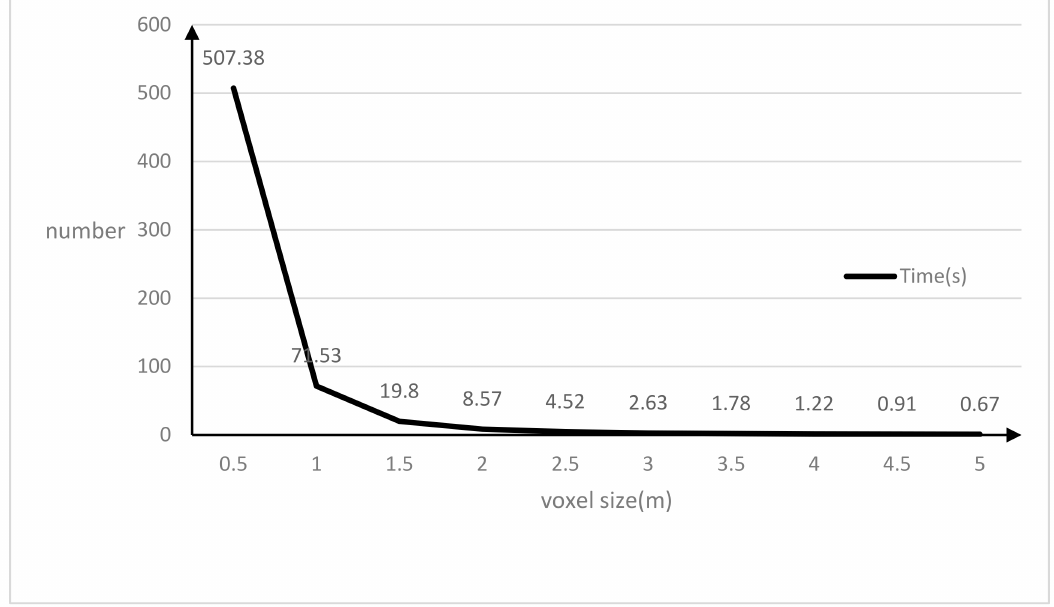
Figure 10. The relationship between the computational time and the voxel size. Table 1. The two-formation geological body statistics table. N1 is the number of the constraint points, N2 is the number of the voxel points of the models, N3 is the number of the voxel points that change their labels, and d vox is the voxel size.